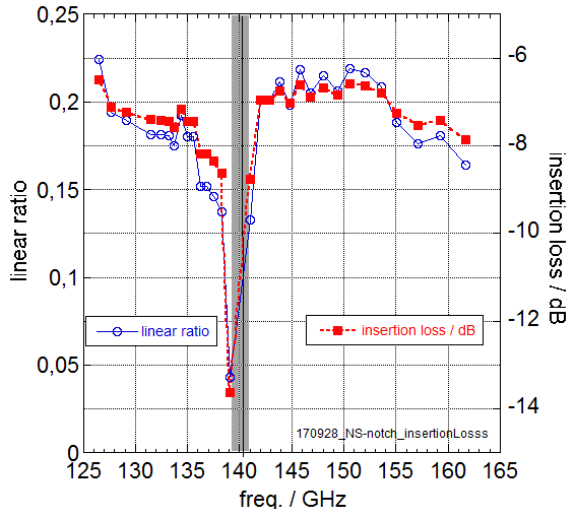
Fig. 4: Insertion loss of the Bragg reflection notch filter measured with a noise source and the radiometer channels. About 2 dB of the measured values account for the tapers and waveguides used for the measurement itself. The overall insertion loss is 5 dB in the probed frequency band. Ch16 and 17 are already at the edge of the notch and thus difficult to